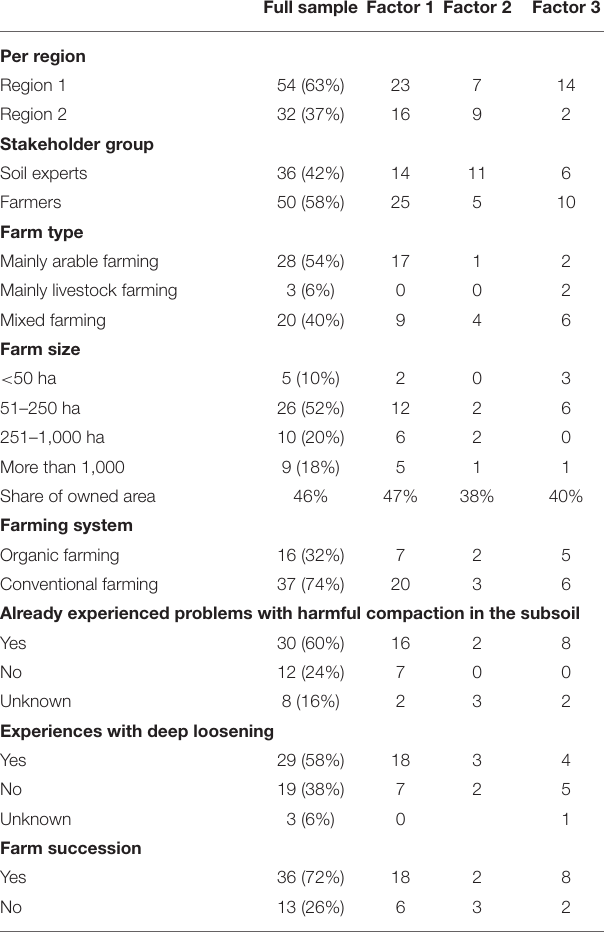
TABLE 3 | Description of